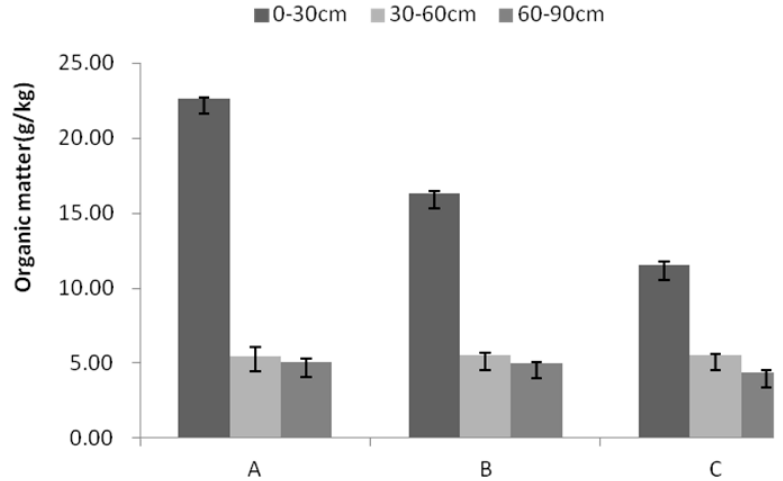
Figure 4. The contents of organic matter (OM) in the three systems. System A (planting Pennisetum sinese Roxb ) and system B (planting Pennisetum purpureum Schum. ) had higher values than system C (no plant).